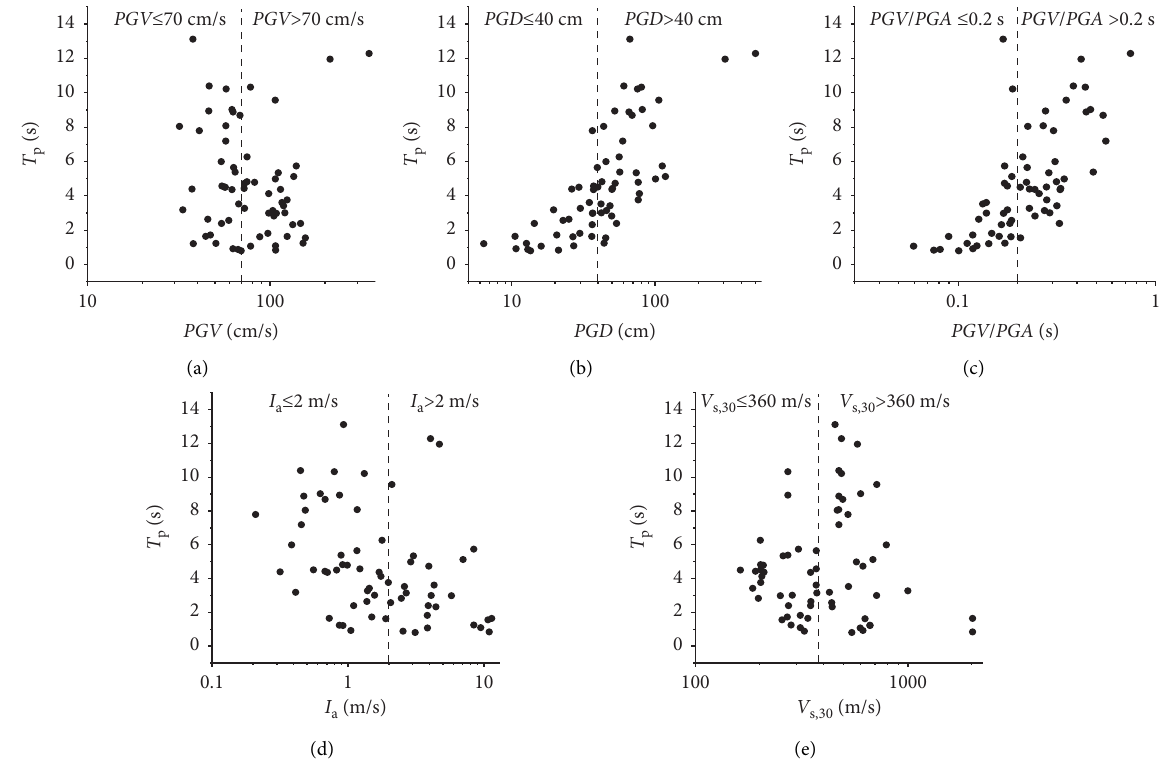
Figure 12: Scatter plot of (a) PGV, (b) PGD, (c) PGV/PGA, (d) I